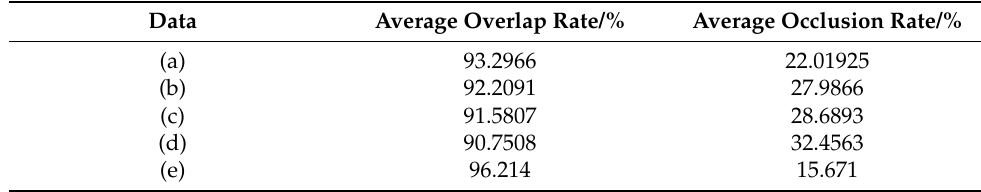
Figure 12. 5 sets of matching situations in different scenario. ( a ) Mario; ( b ) robot; ( c ) face; ( d ) doll; ( e ) Peter Rabbit. Table 2. 5 sets of data recognition results.